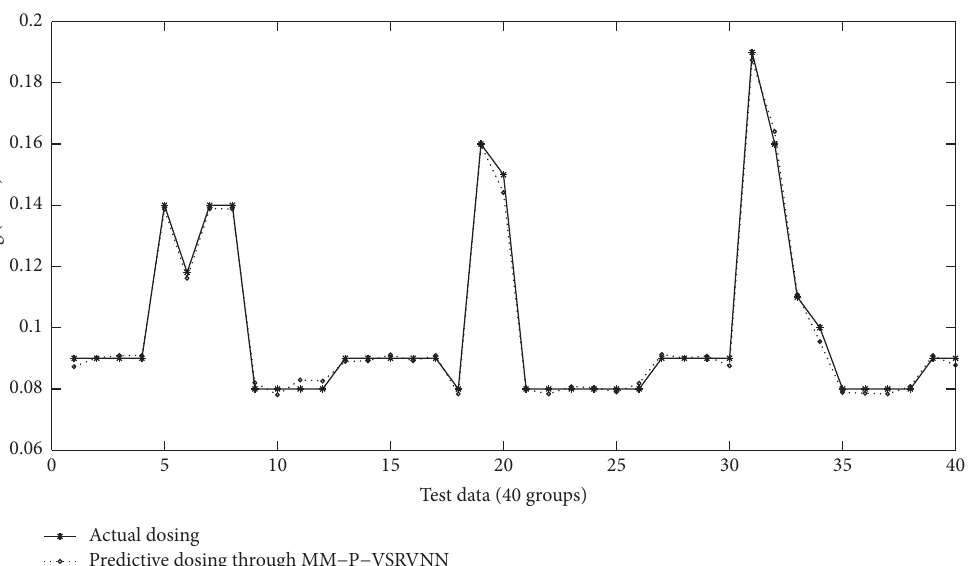
Figure 6: Prediction and actual value of coagulant dosage.